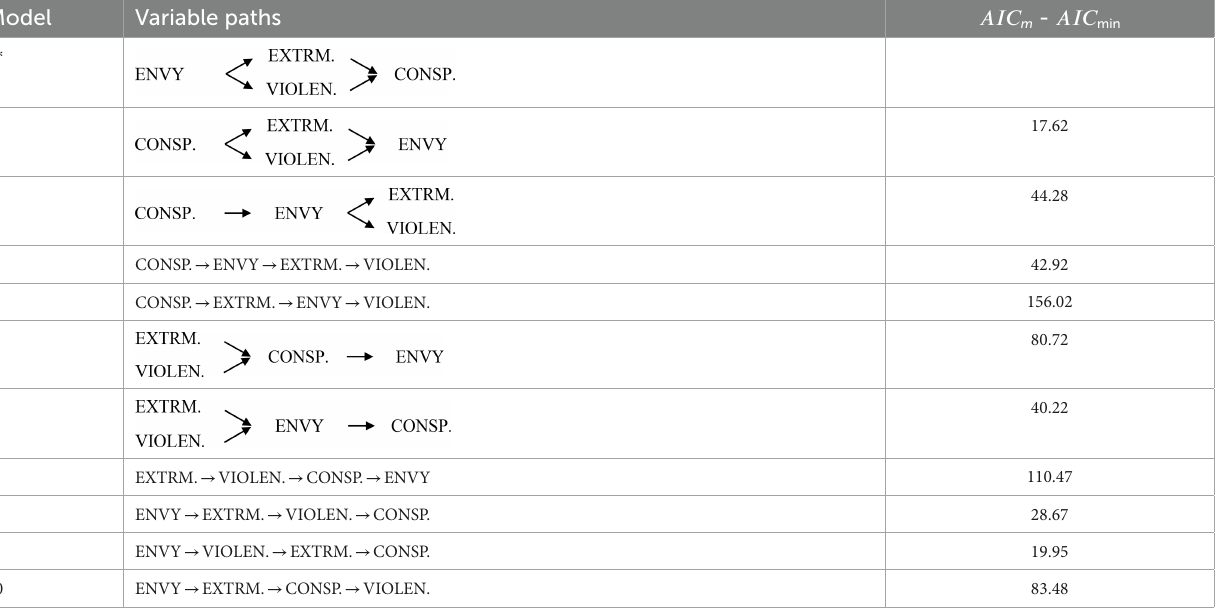
TABLE 3 AIC comparison of alternative models. Model Variable